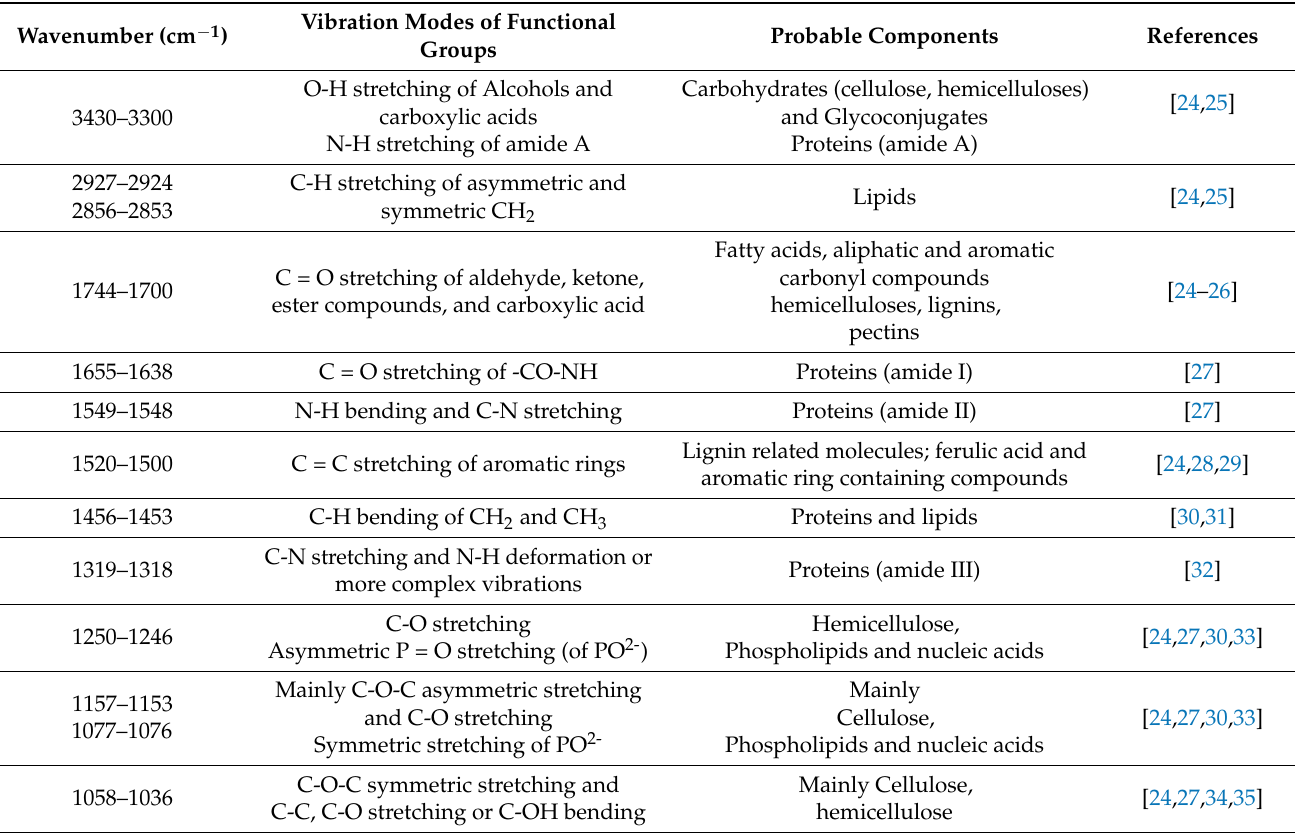
Table 1. The tentative assignment of FTIR absorption peaks of wheat root samples-based on literature (Web of Science) data (see references). The wavenumbers presented in the table are the ranges for the mean values of the control and fungal